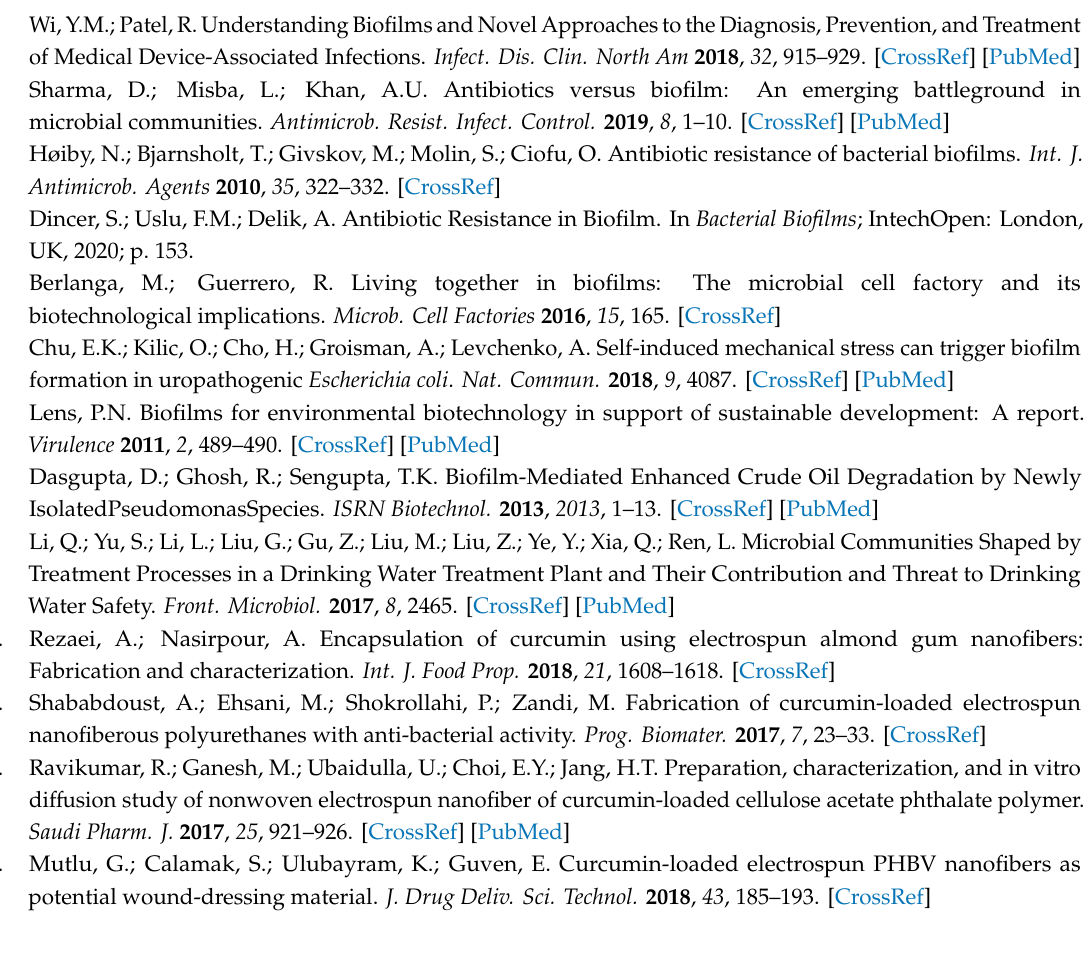
Figure S1: 1H NMR of PCL control (CDCl3), Figure S2: Relative growth of exposed bacteria to di ff erent concentrations of CUR. (A) Escherichia coli , (B) Pseudomona aeruginosa , (C) Staphylococcus aureus , Figure S3: SEM images of exposed PCLc and PCL / CUR sca ff olds with bacteria after 12 h of incubation. (A) Escherichia coli on PCLc fibers (500 × ), (B) Pseudomona aeruginosa on PCLc fibers (3000 × ), (C) Staphylococcus aureus on PCLc fibers (3000 × ), (D) Escherichia coli on PCL / CUR1 fibers (1000 × ), (E) Pseudomona aeruginosa on PCL / CUR1 fibers (1600 × ), (F) Staphylococcus aureus on PCL / CUR1 fibers (3000 × ), (G) Escherichia coli on PCL / CUR2 fibers (4000 × ), (H) Staphylococcus aureus on PCL / CUR2 fibers at (6000 × ), (I) Staphylococcus aureus on PCL / CUR2 fibers (3000 × ), (J) Escherichia coli on PCL / CUR3 fibers (12,000 × ), (K) Staphylococcus aureus on PCL / CUR3 fibers at (6000 × ), (L) Staphylococcus aureus on PCL / CUR3 fibers (3000 × ), Figure S4: 1H NMR spectra of curcumin control in CD3OD (* residual solvent signals), Figure S5: 1H NMR spectra of curcumin control in DMSO6 (* Residual solvent signals), Figure S6: Comparison between curcumin leaves in CD 3 OD (A) and DMSOd 6 (B). (* Residual signals in deuterated solvents), Figure S7: Comparison of 1 H RMN spectra of (A) PCL control electrospun fibers in CDCl 3 , (B) PCL-CUR4 fibers in CDCl 3 and (C) CUR control (CD 3 OD), Figure S8: Comparison between (A) CUR leaves in DMSOd 6 , (B) CUR leaves in CD 3 OD, (C) PCL control fibers (CDCl 3 ) and (D) PCL-CUR4 fibers (CDCl 3 ), * Residual signals of deuterated